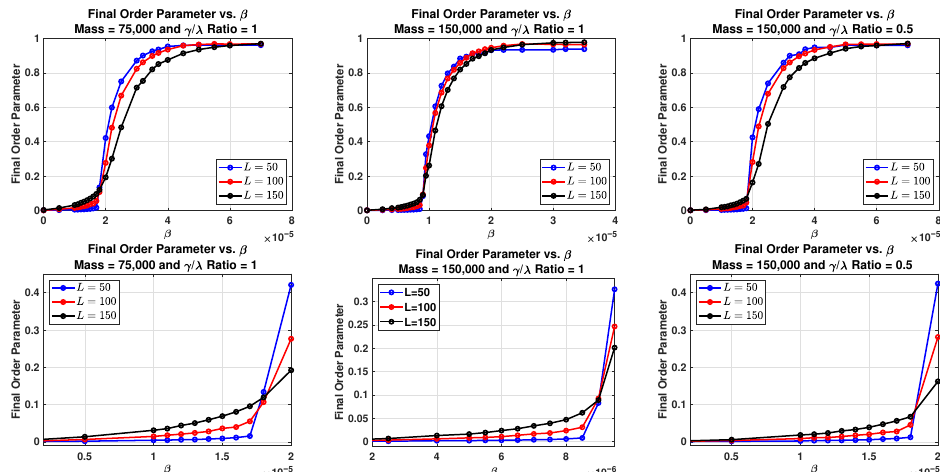
Figure 5. The Effect of Parameters on the Phase Transition. Here we have N 1 = N 2 = N 3 = 50,000, with λ = γ = 0.5 and δ t = 1. The order parameter values were computed after 100,000 time steps. On the top three plots, it is seen that for small β values, the system remains well-mixed and the resulting order parameter values is approximately zero over time. However, for larger β values we see that the order parameter increases quickly as the system segregates and levels off to around one. We clearly see that as the β value increases there is a critical β value in which a phase transition occurs. The plots also show the effects of changing the lattice grid, mass and the ratio γ / λ . The bottom three plots are magnified versions of the top three